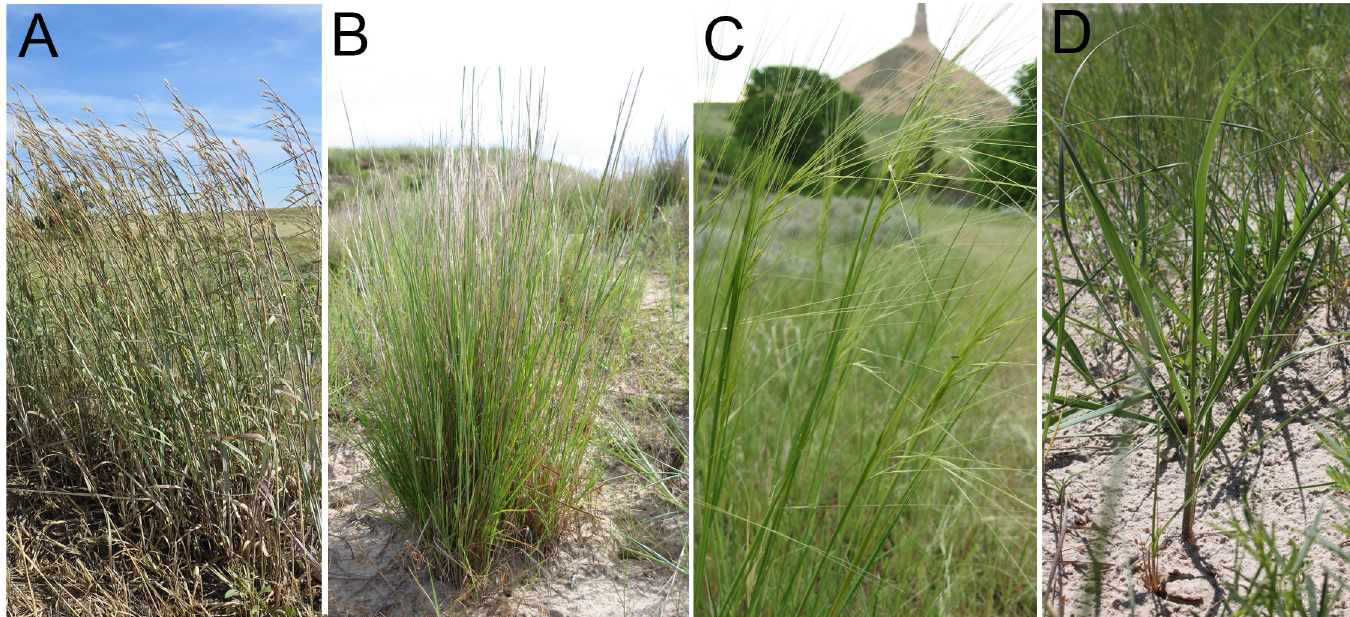
Fig 2. Grasses surveyed in the study. Shown are: A) sand bluestem ( Andropogon hallii Hack), B) little bluestem ( Schizachyrium scoparium ), C) needle-and-thread ( Hesperostipa comata ), and D) prairie sandreed ( Calamovilfa longifolia ).